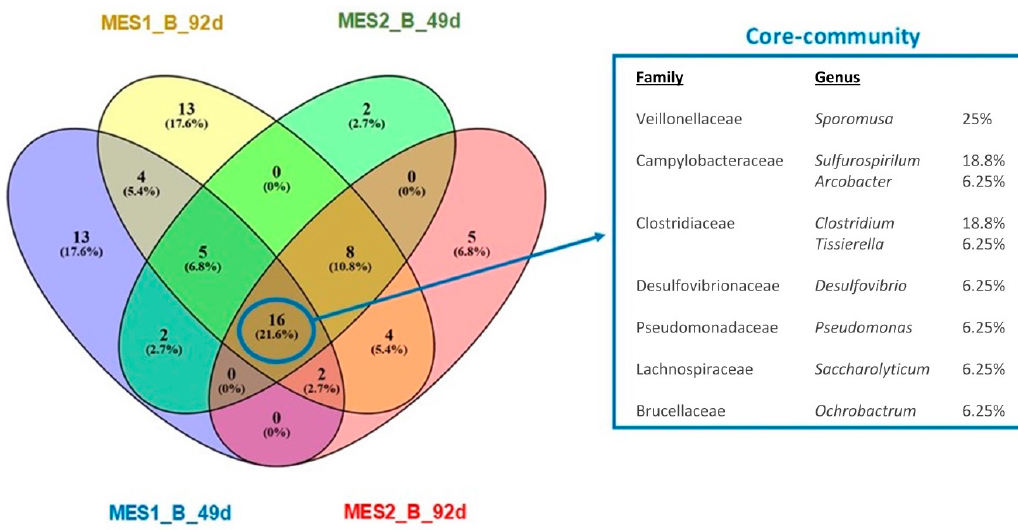
Figure 6. Overlap of the four biofilm communities and the taxonomic identities of the shared OTUs.